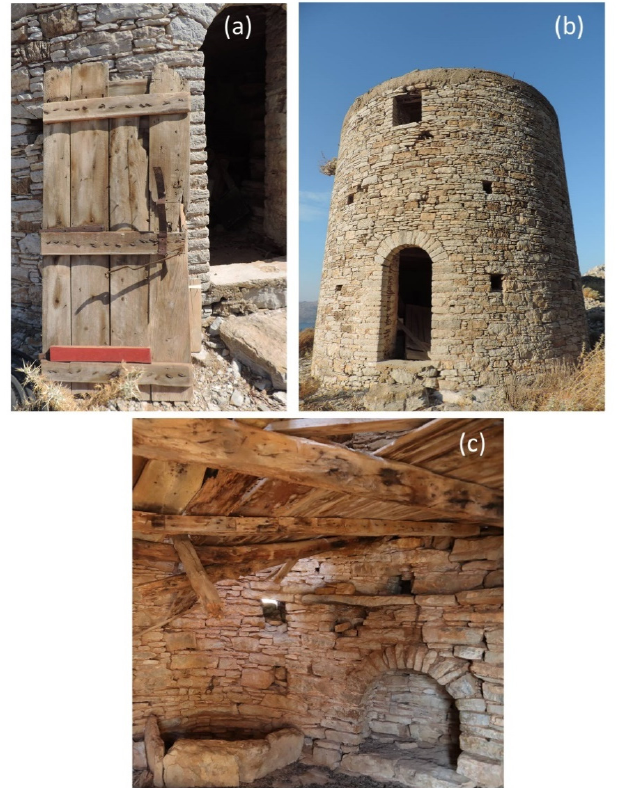
Figure 2. Historical timber examined in the current study: ( a ) one of the examined doors; ( b ) one of the standing windmills on a hill to the east of Ano Symi; ( c ) its interior.